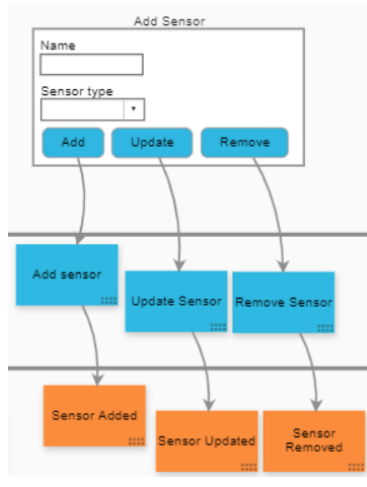
Figure 6 . Eventmodeling of Sensor